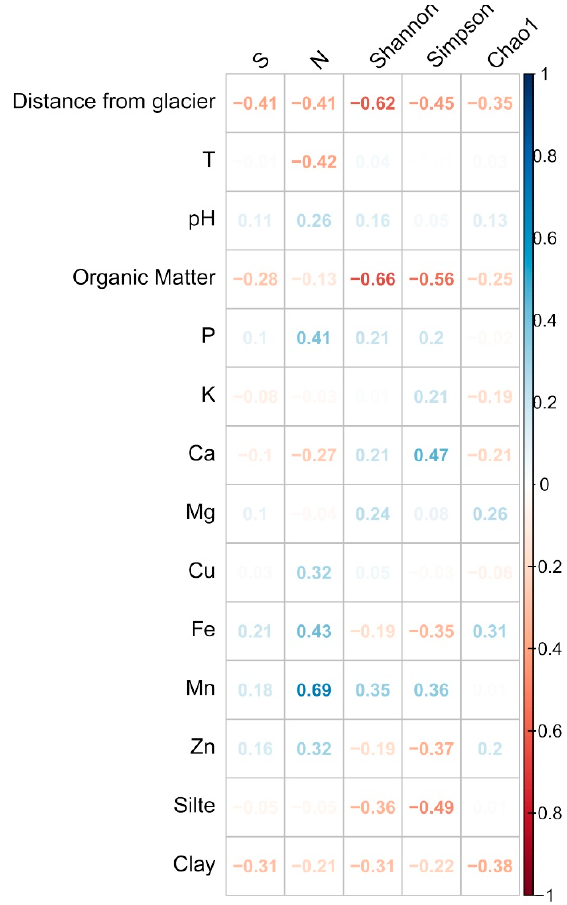
Figure 5. Pearson’s correlation between the diversity indices and environmental data.